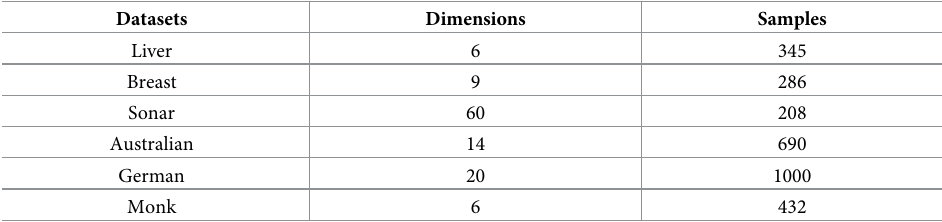
Table 3. Selected datasets in